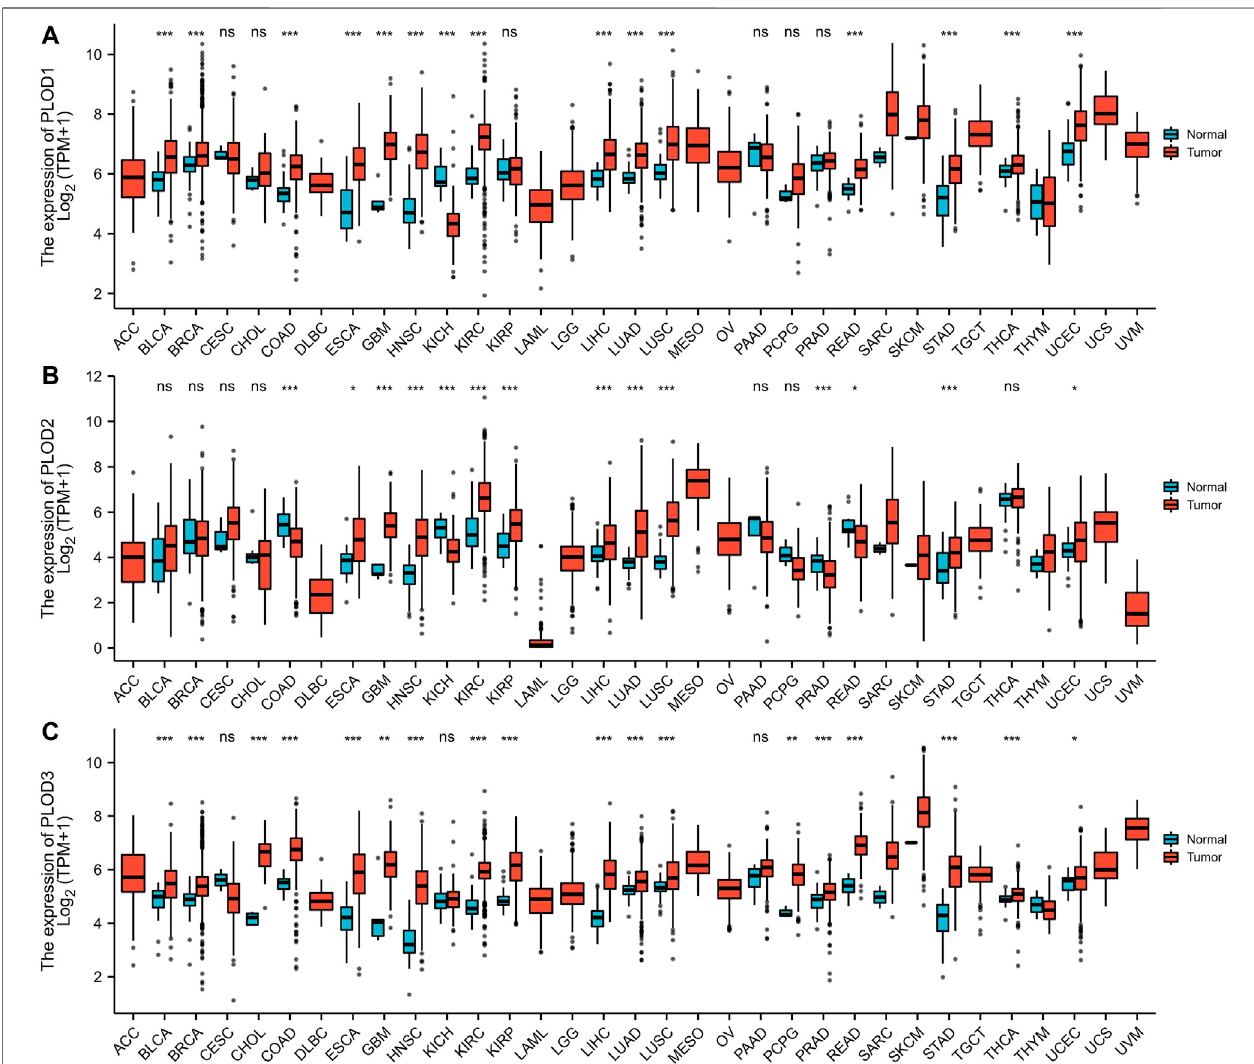
FIGURE 1 | Pan-cancer analyses. (A) mRNA expression of PLOD1 upregulated in 14 of 33 cancer types; (B) mRNA expression of PLOD2 upregulated in 11 of 33 cancer types; (C) mRNA expression of PLOD3 upregulated in 17 of 33 cancer types. * p < 0.05, * p < 0.01, *** p < 0.001. ns, no signi fi cance; ACC, adrenocortical carcinoma;BLCA,bladderurothelialcarcinoma;BRCA,breastinvasivecarcinoma;CESC,cervicalsquamouscellcarcinomaandendocervicaladenocarcinoma;CHOL, cholangiocarcinoma;COAD,colonadenocarcinoma;DLBC,lymphoidneoplasmdiffuselargeB-celllymphoma;ESCA,esophagealcarcinoma;GBM,glioblastoma multiforme; HNSC, head and neck squamous cell carcinoma; KICH, kidney chromophobe; KIRC, kidney renal clear cell carcinoma; KIRP, kidney renal papillary cell carcinoma; LAML, acute myeloid leukemia; LGG, brain lower grade glioma; LIHC, liver hepatocellular carcinoma; LUAD, lung adenocarcinoma; LUSC, lung squamous cell carcinoma; MESO, mesothelioma; OV, ovarian serous cystadenocarcinoma; PRAD, prostate adenocarcinoma; PCPG, pheochromocytoma and paraganglioma; READ, rectum adenocarcinoma; SARC, sarcoma; SKCM, skin cutaneous melanoma; STAD, stomach adenocarcinoma; THCA, thyroid carcinoma; THYM, thymoma; UCEC, uterine corpus endometrial carcinoma; UCS, uterine carcinosarcoma; UVM, uveal melanoma.